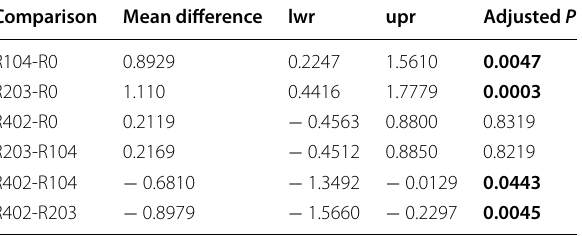
Table 1 Tukey’s honest significance difference for the pairwise comparisons for every